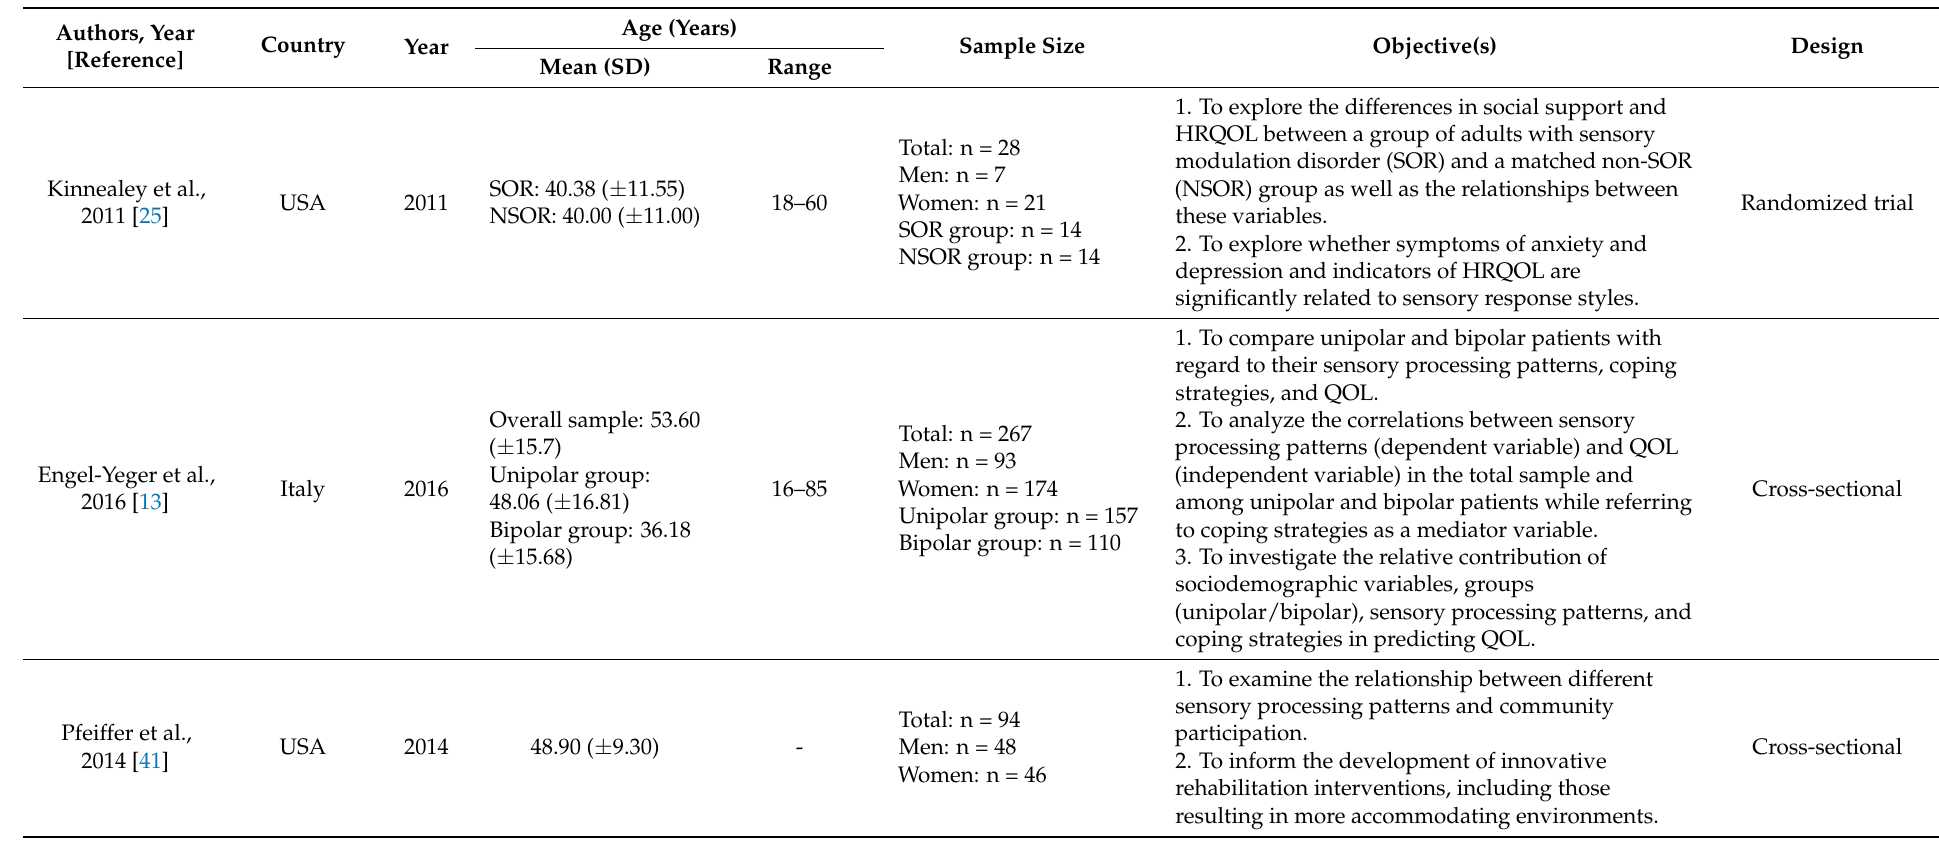
Table 2. Description of the studies included in the